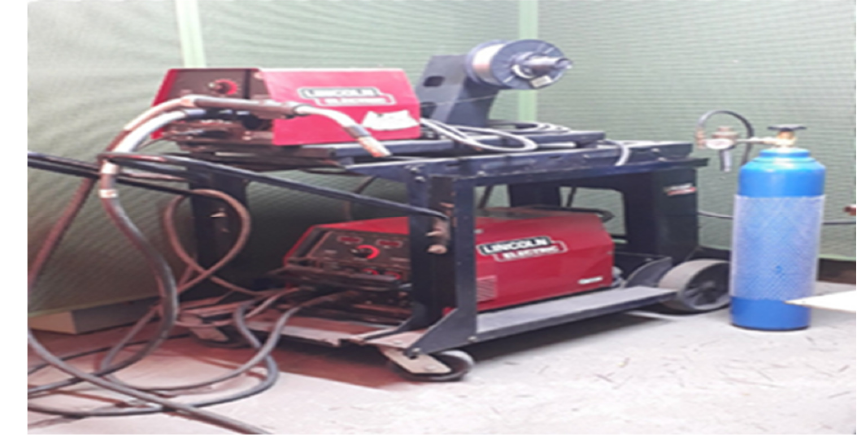
Fig. 2. Lincoln electric machine used in this